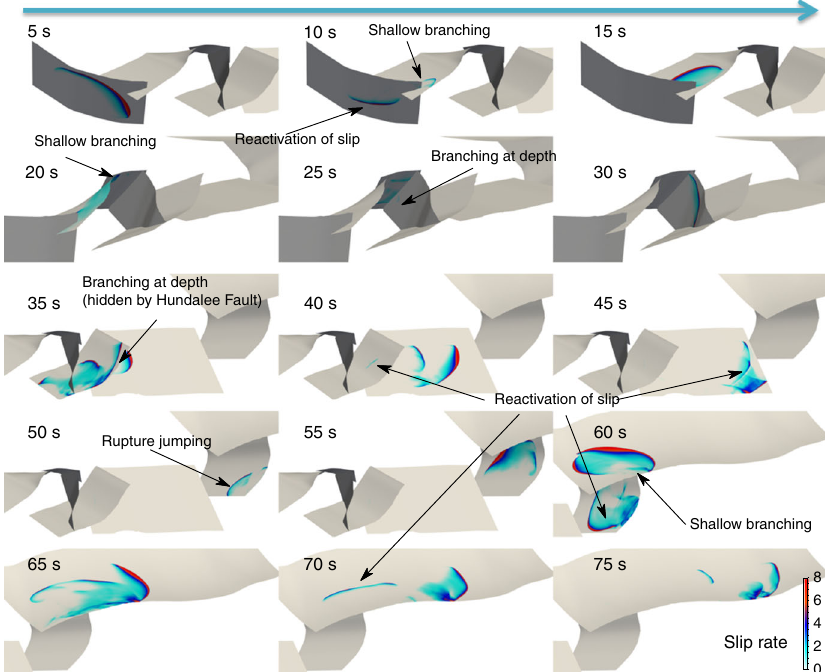
Fig. 4 Overview of the simulated rupture propagation. Snapshots of the absolute slip rate are shown every 5 s. The fi gure focuses on four different portions of the fault system, following the rupture front as it propagates from South to North. Labels indicate remarkable features of the rupture discussed in